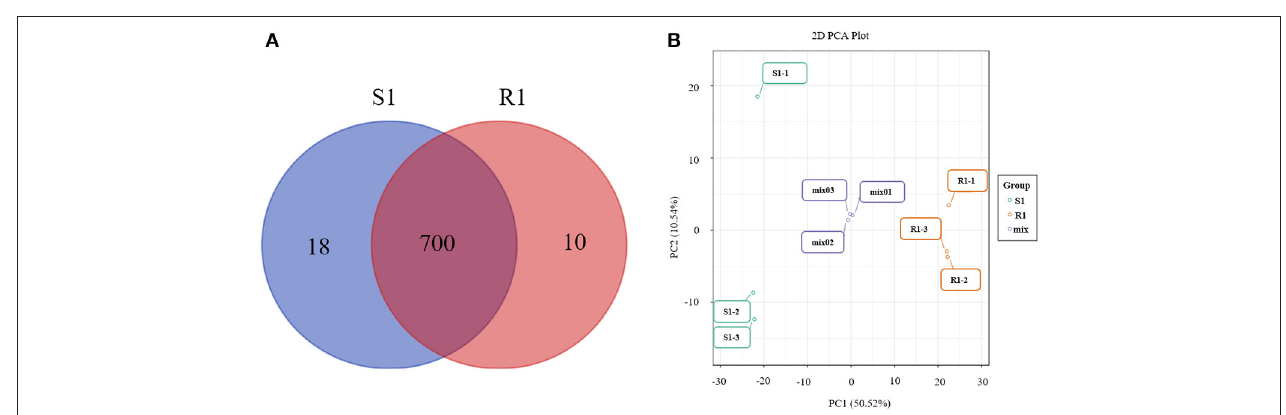
FIGURE 3 | Venn diagrams of metabolites detected in each group (A) and principal component analysis (PCA) score plot for mass spectrum data of tea samples and quality control samples (B) . The X -axis represents the first principal component (PC1) and the Y -axis represents the second principal component (PC2) in the PCA score